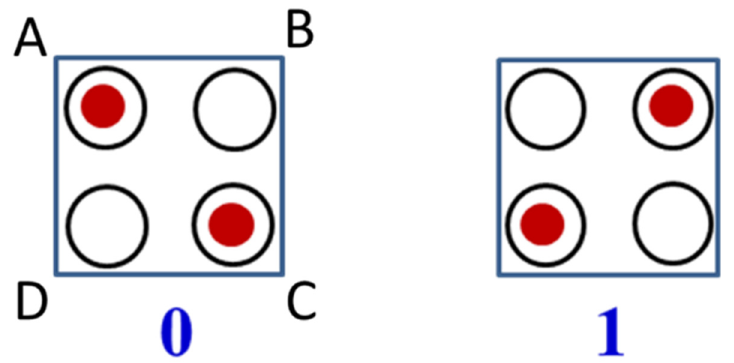
Figure 1. Scheme of a square-planar cell encoding binary information 0 and 1 in the two diagonal positions of the electronic pair denoted by red balls. The labels of the dots A, B, C, D used through the article are also shown.